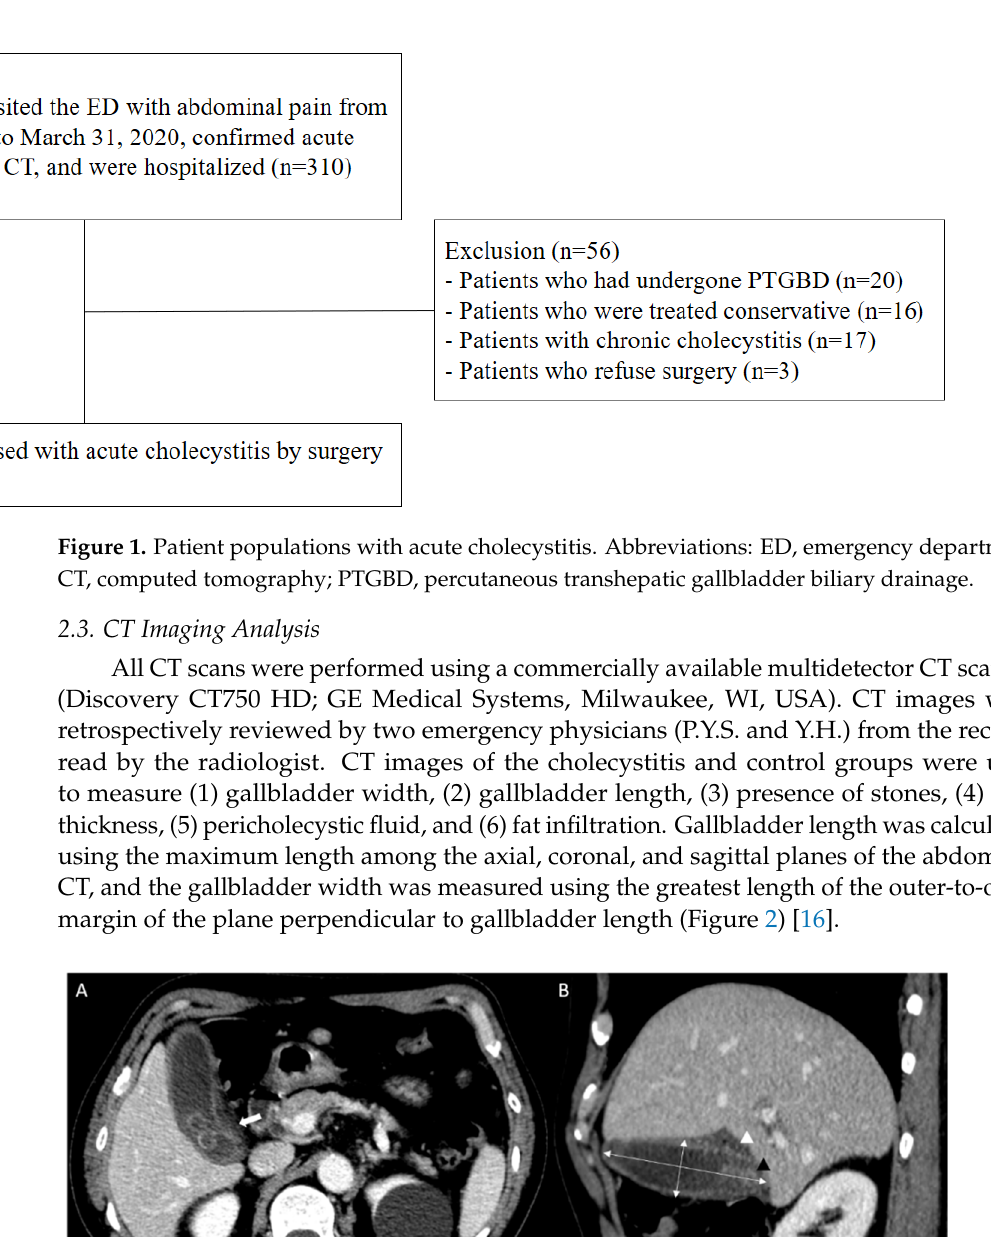
Figure 1. Patient populations with acute cholecystitis. Abbreviations: ED, emergency department; CT, computed tomography; PTGBD, percutaneous transhepatic gallbladder biliary drainage.